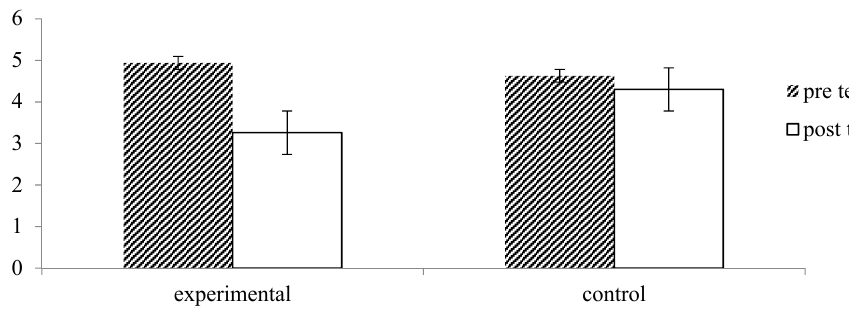
Figure 6. Effect of forest therapy on the Visual Analog Scale for Pain (VAS Pain), with scores ranging from 0 = least possible pain to 10 = worst possible pain.